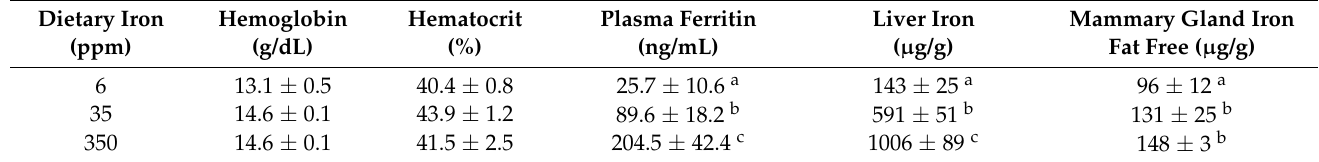
Table 1. Effect of dietary iron on host iron